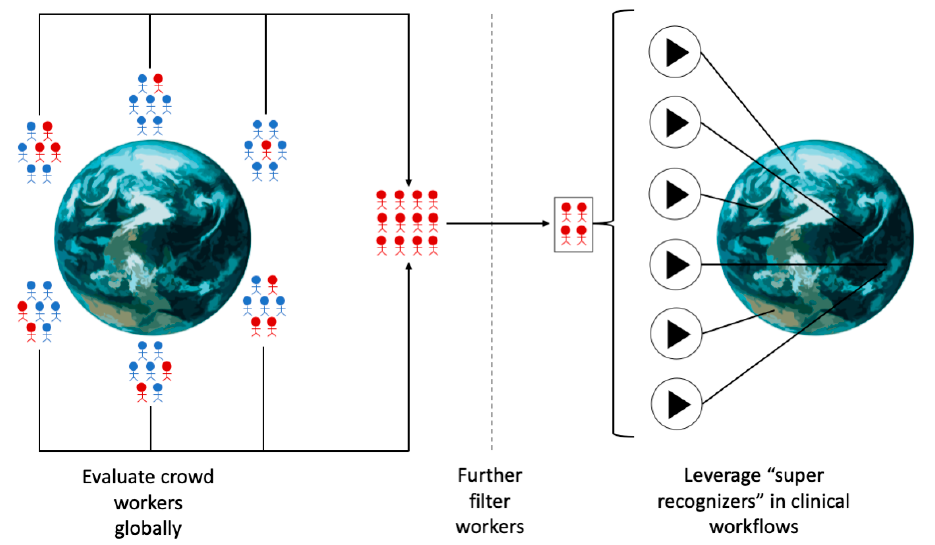
Figure 5. Crowd filtration pipeline. Crowdsourced workers are first evaluated globally. The highest performers from each location are further evaluated for one or more rounds until a final skilled workforce is curated. These “super recognizers” may then be repeatedly employed in global clinical workflows.